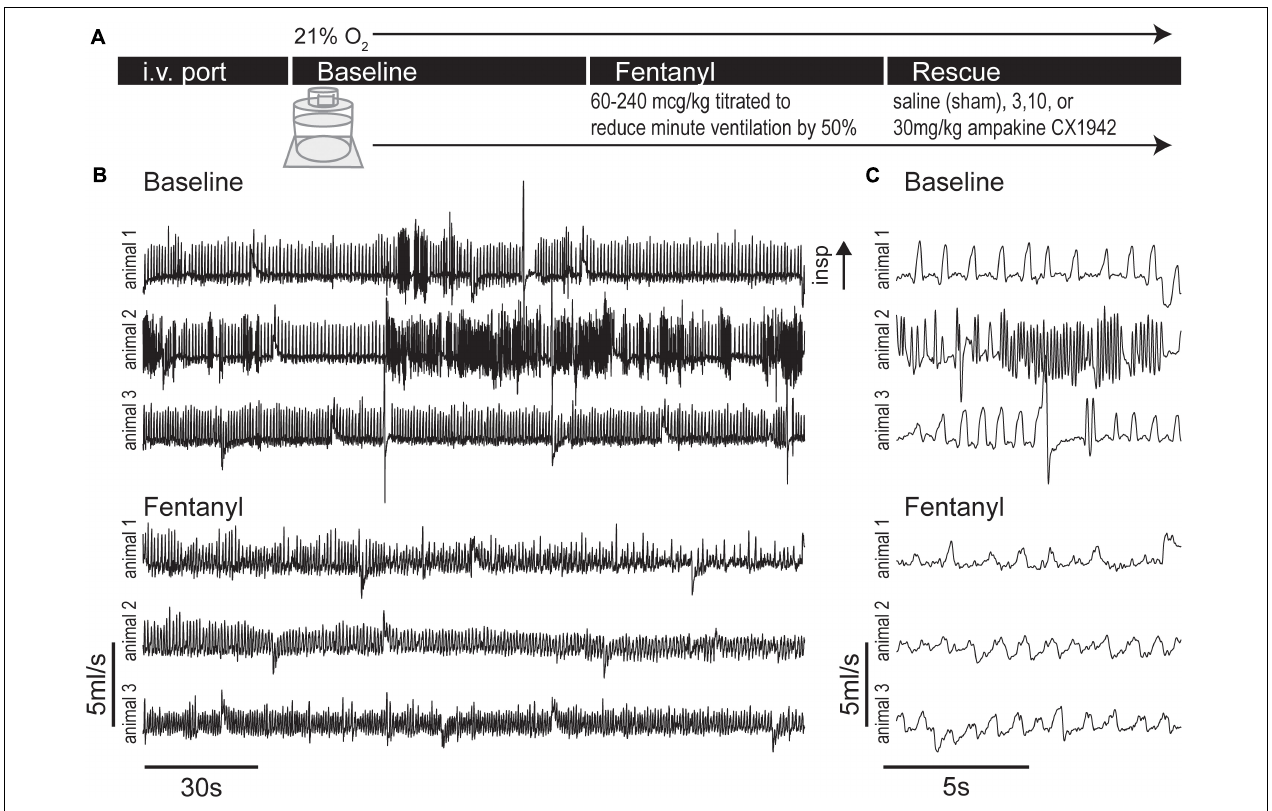
FIGURE 2 | Experimental protocol and example plethysmography traces during baseline and fentanyl periods. (A) Experimental timeline, rats were lightly anesthetized with isoflurane to place an i.v. port in the tail vein, then rats were placed in whole body flow through plethysmography chamber (21% O 2 balance N 2 ), after a 32 ± 7 min (mean ± SD) baseline period fentanyl was infused until minute ventilation dropped to 50% of baseline levels. A rescue dose (3, 10, or 30 mg/kg) of ampakine CX1942 or control (saline) was then injected. (B) Example flow traces showing the baseline and fentanyl period from three rats. Under baseline conditions, the varied nature of rat respiration produced waveforms indicative of switching between multiple behaviors (e.g., quiet breathing and sniffing). However, injection of fentanyl caused respiratory waveforms to exhibit less variation and decrease in amplitude. (C) Expanded traces from panel (B)